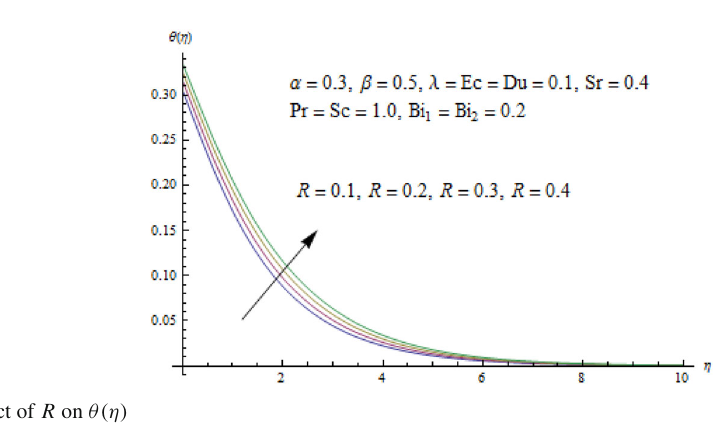
Fig. 13 Impact of β on θ(η)